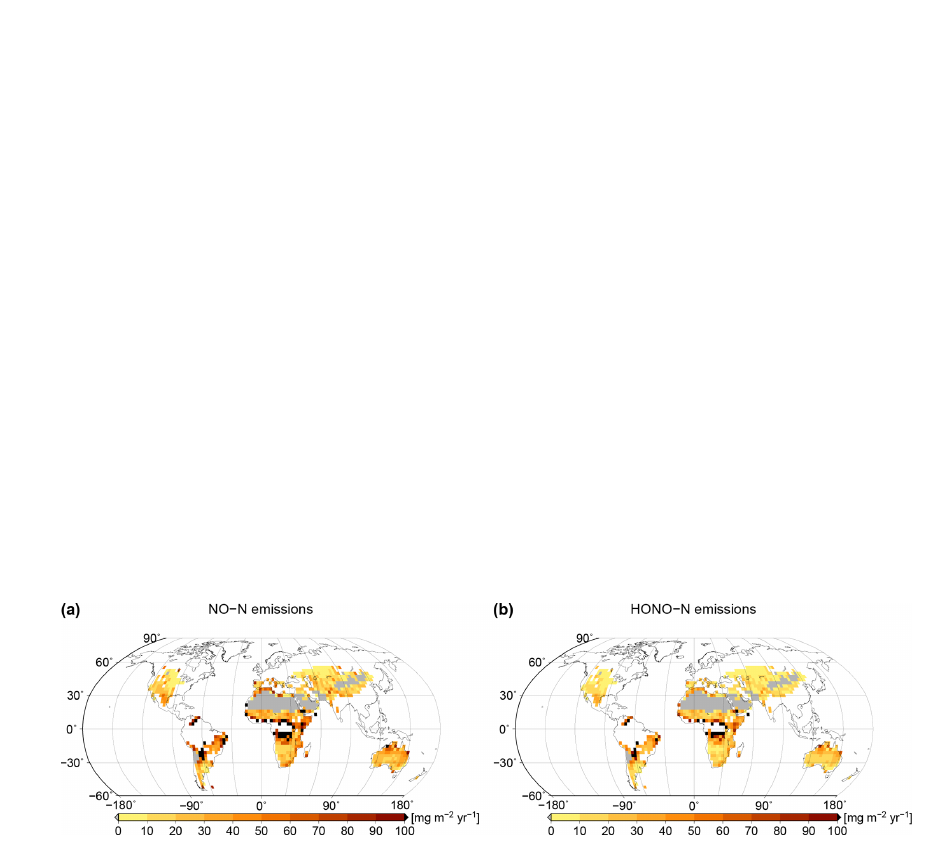
Figure A8. Global patterns of (a) NO and (b) HONO emissions simulated by LiBry, in units of units of milligrams of nitrogen per metre squared per year. White areas denote excluded regions, while grey areas correspond to regions where no simulated strategies are able to survive. Contrary to the standard model setup, the study region is only constrained by biome type; no maximum amount of annual rainfall is considered. Total global NO and HONO emissions by biocrusts amount to 2.48Tgyr − 1 NO–N and 1.69Tgyr − 1